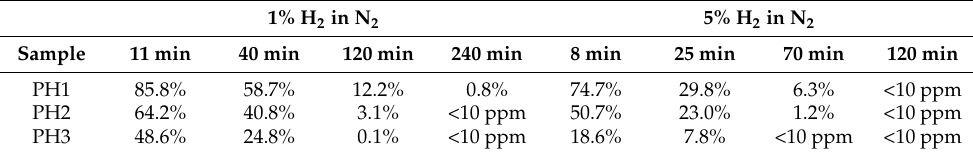
Table 2. Normalized H 2 concentration with time for PH1-PH3 under 1% and 5% H 2 test conditions.